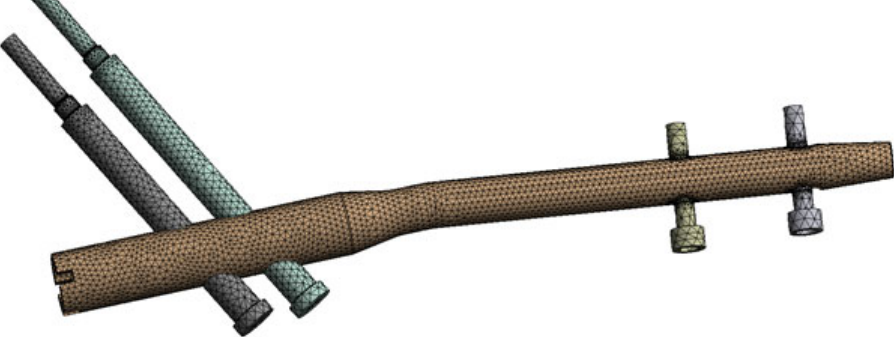
Figure 11. Finite element mesh for a Medin 125° nail.